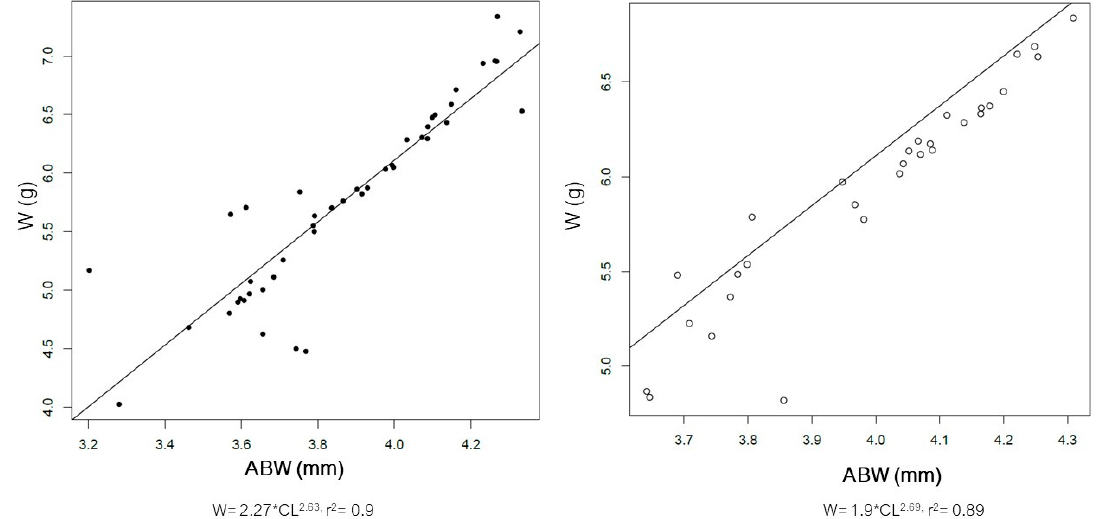
Figure 7. Relationship between abdominal width (ABW) and weight (W) of the male ( left ) and female ( right ) spiny lobsters Panilurus elephas from the Thermaikos Gulf. The linear regression was performed and plotted with R. Data presented after log-transformation.